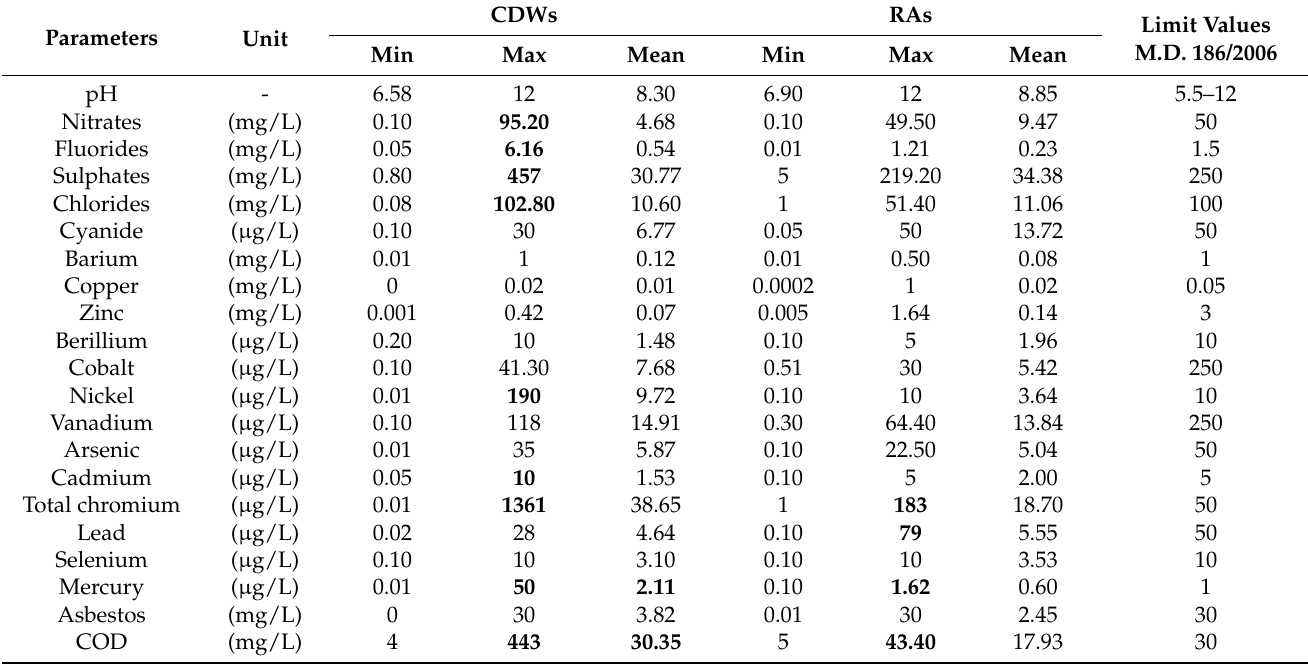
Table 4. Leaching properties of CDWs and RAs (contaminant releases reported in the average and minimum– maximum